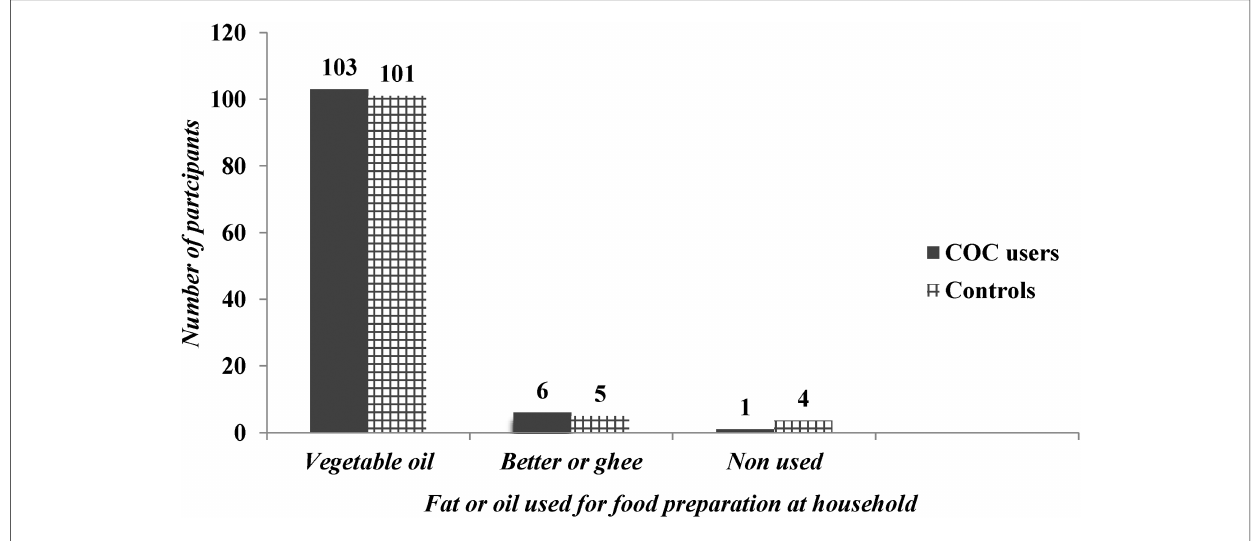
FIGURE 2 Nutritional Status of OCPs users and controls in chencha town, southern Ethiopia.